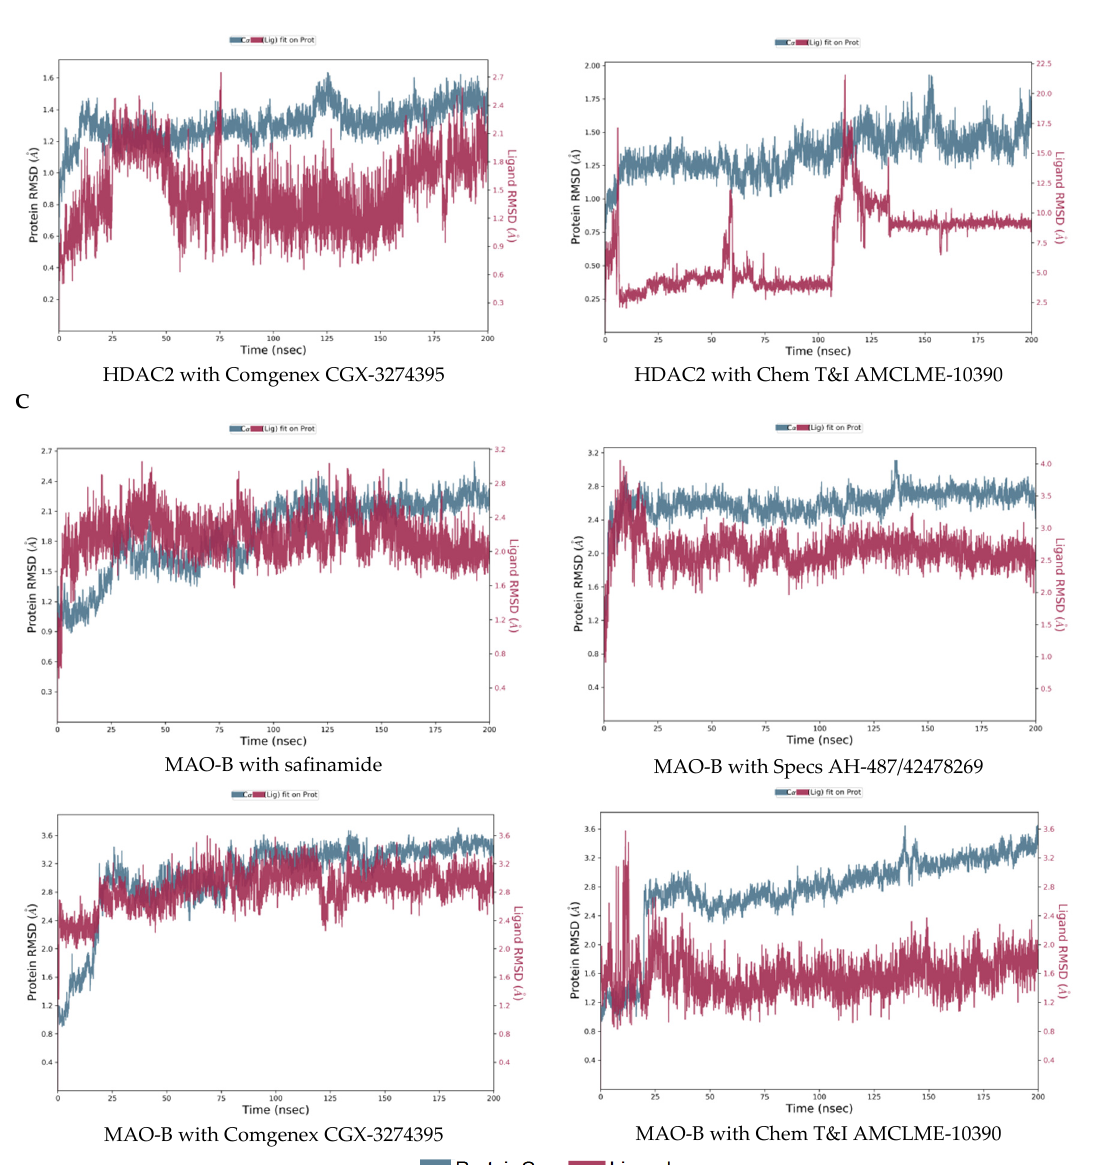
Figure 6. Calculated RMSDs (Å) of the displacements of the protein-ligand complexes over the MD simulation time: ( A ) AChE with reference ligand/hit ligands; ( B ) HDAC2 with reference ligand/hit ligands; ( C ) MAO-B with reference ligand/hit ligands.